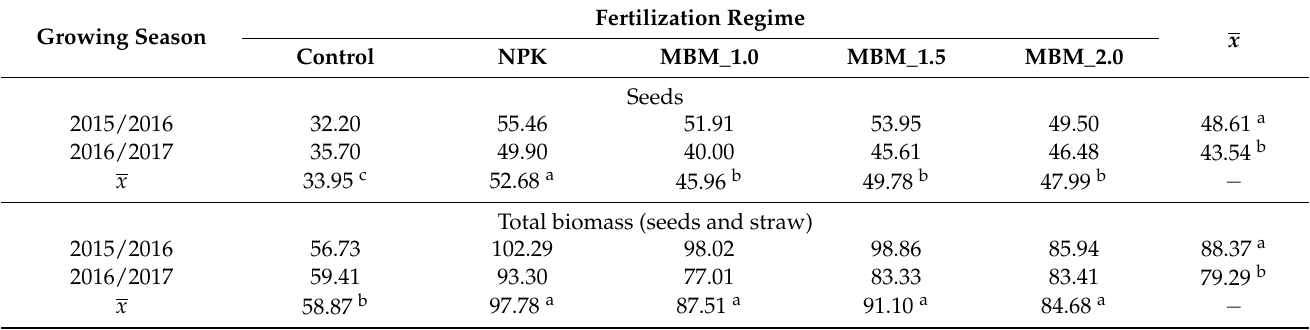
Table 10. Energy gain in the production of winter oilseed rape (GJ ha − 1